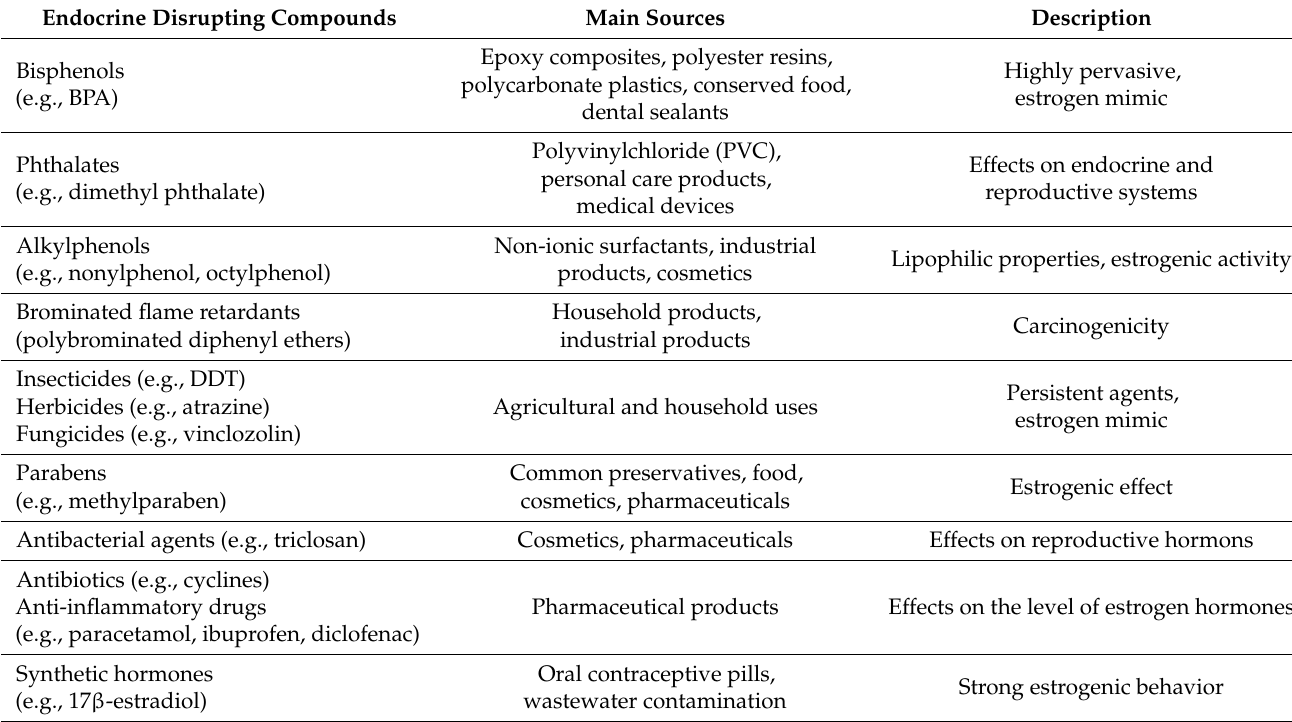
Table 1. Summary of the most used EDCs impacting the immune